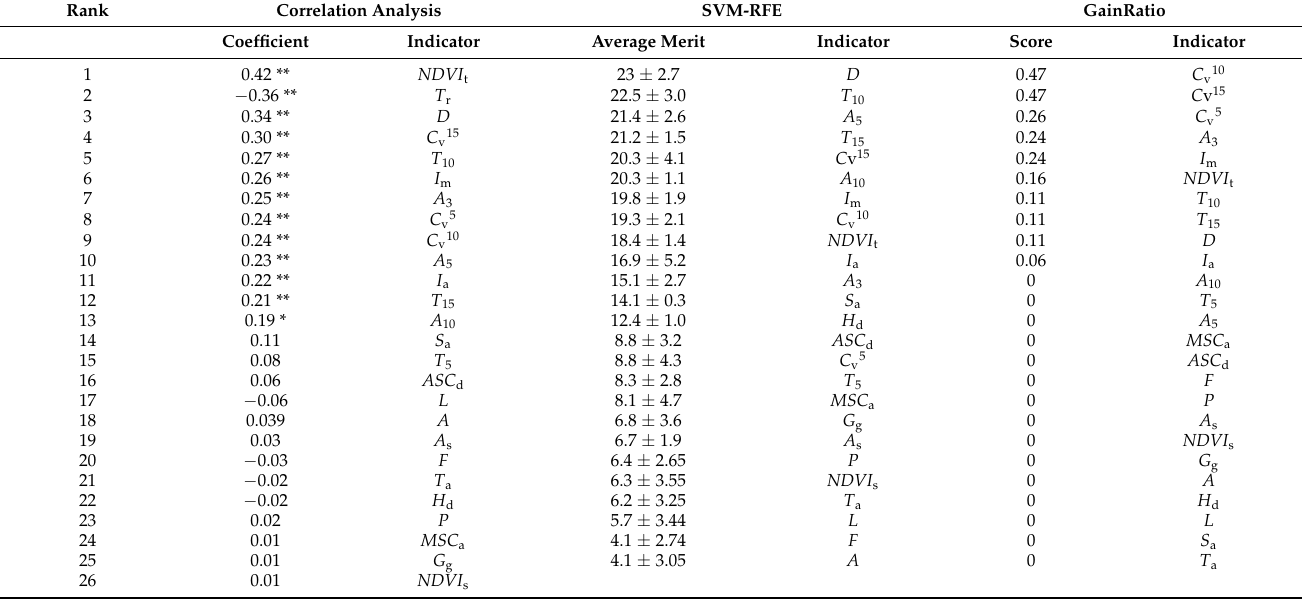
Table 8. Assessment methods of indicator selection and related